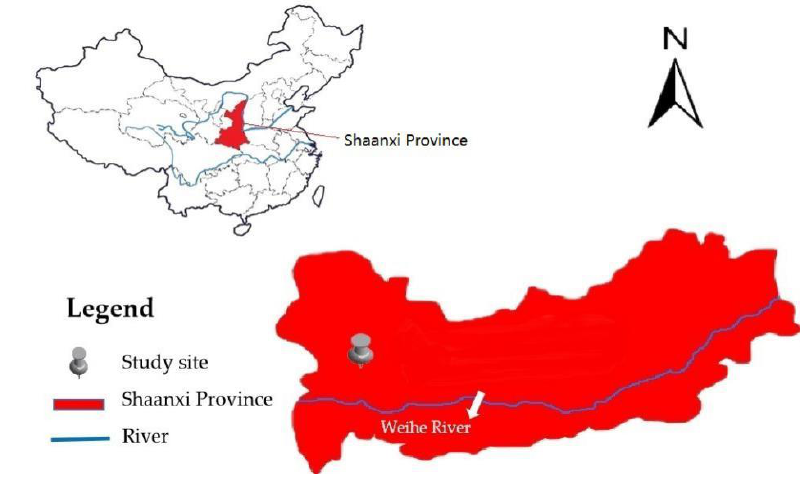
Figure 1. Location of the study area.